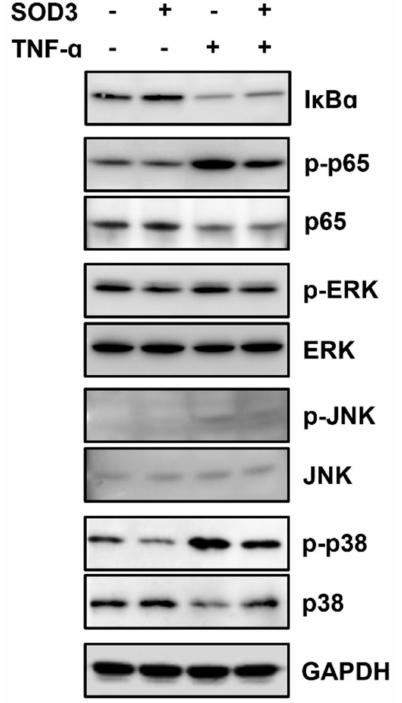
Figure 5. Effects of SOD3 on the level of I κ B and phosphorylation of NF- κ B p65 and MAPKs in fibroblasts. Human foreskin fibroblasts were incubated without serum in the presence of TNF- α (1 ng/mL) and/or SOD3 (3 µ g/mL) for 12 h. The phosphorylation and expression levels of I κ B α , NF- κ B p65, ERK, JNK, and p38 MAPK were assessed via western blotting